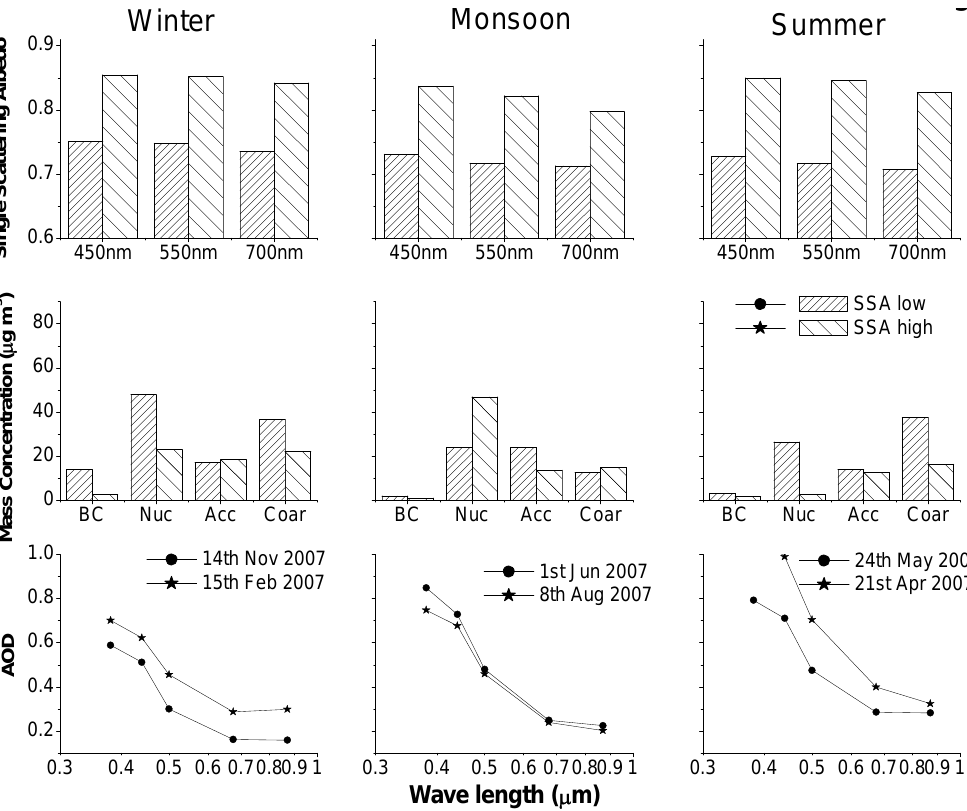
Fig. 8. Variation of SSA (at 550nm, top panel), surface aerosol mass concentrations (in µgm − 3 ) in the three modes along with the BC mass concentration (in µgm − 3 middle panel), and spectral AOD for the selected days which do not fall in the mean pattern (bottom panel).